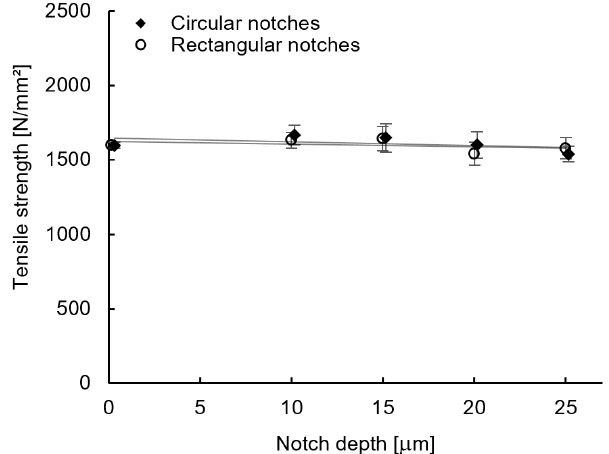
Figure 8. Average values of the tensile strength and standard deviation for z-pinned reinforced unidirectional carbon-fibre/epoxy composites with notched z-pins, circumferentially notched with rectangular and circular notches with constant notch width and distance of 100 µ m each, depending on the notch depth; the values for a notch depth of 0 µ m correspond to the values for unnotched